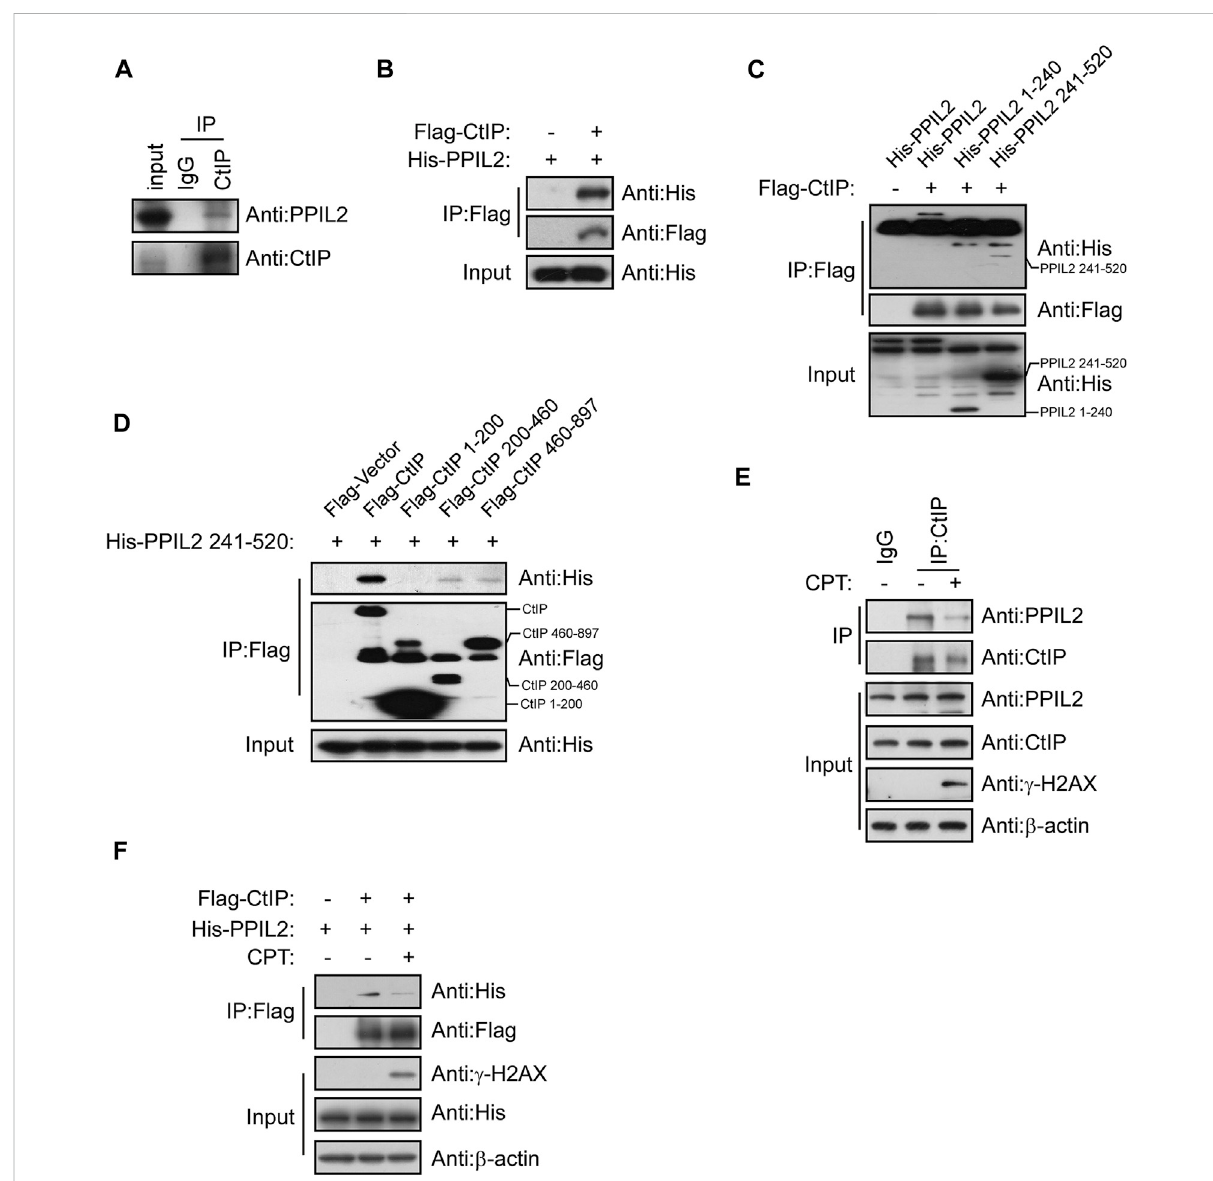
FIGURE 3 PPIL2interactswithCtIP. (A) WesternblottingofU2OScellslysedinthepresenceofanti-CtIPantibodywithanti-CtIPandanti-PPIL2antibodies show an endogenous interaction between PPIL2 and CtIP. (B) 293T cells were cotransfected for recombinant Flag-CtIP and His-PLK1 expression. IP with anti-Flag and western blotting with anti-His and anti-Flag. (C) 293T cells were cotransfected with His-PPIL2 fragments and Flag-CtIP, followed by IP with Flag and western blot analysis. (D) 293T cells were cotransfected with Flag-CtIP fragments and His-PPIL2 241 – 520, followed by IP with Flag and western blot analysis. (E) Co-IP assay probing PPIL2-CtIP interaction in U2OS cells treated with 2 μ M CPT for 1 h (F) 293T cells were cotransfectedwithFlag-CtIPandHis-PPIL2andtreatedwithorwithout2 μ MCPTfor1 h.TheassociationbetweenPPIL2andCtIPwasanalysedbyIP with Flag and western